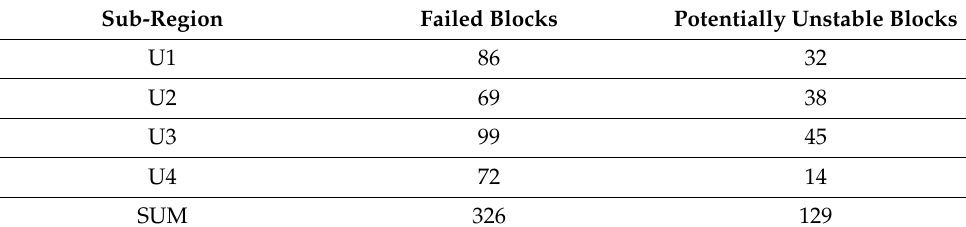
Table 4. The distribution of the already failed and the potentially unstable rock blocks per sub-region. Sub-Region Failed Blocks Potentially Unstable Blocks